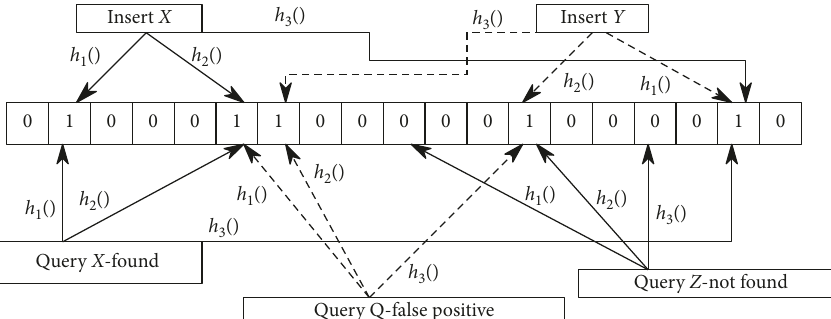
Figure 3: Conventional Bloom filter with k